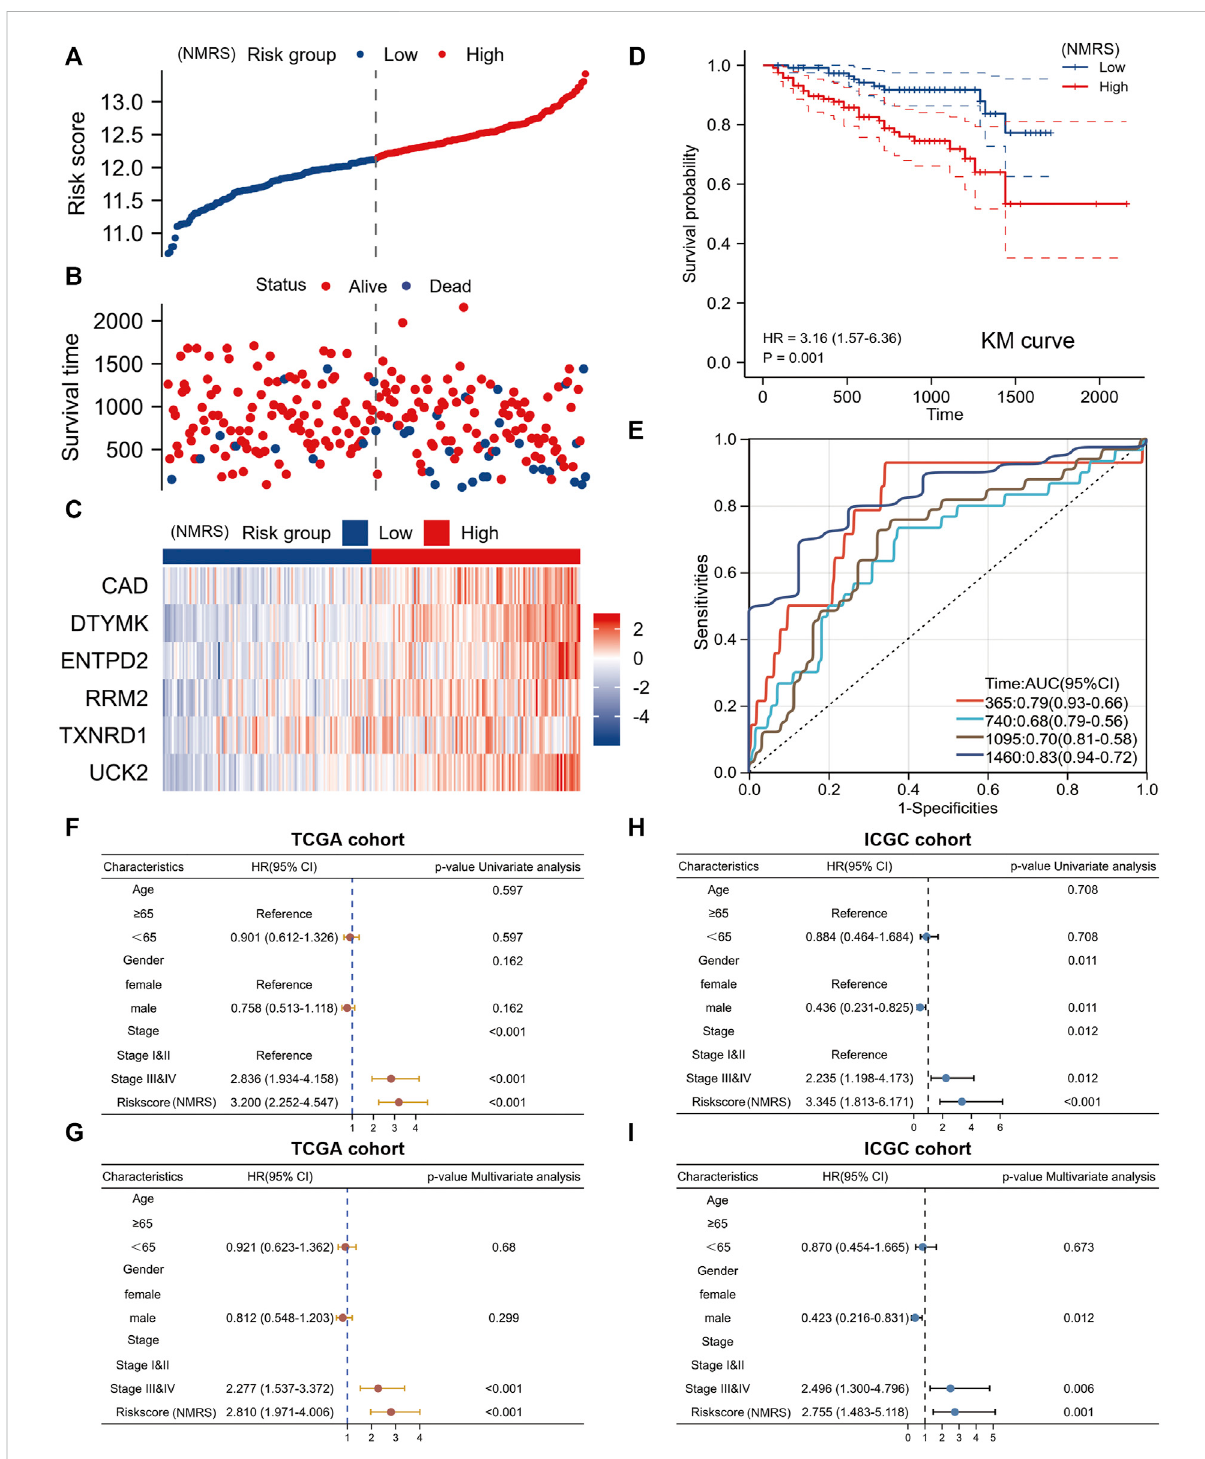
FIGURE 5 External validation set to verify model ef fi ciency. (A) NMRS of patients in the ICGC dataset are calculated based on formula. (B) The high NMRS group in the ICGC dataset has more dead patients. (C) Differences in expression of six genes in the ICGC database between high and low NMRS groups. (D) Prognostic differences between high and low NMRS groups in the ICGC database. (E) Time-dependent ROC curve of ICGC database. (F,G) UnivariateCoxandmultivariateCoxanalysesofNMRSintheTCGAdatabase. (H,I) UnivariateCoxandmultivariateCoxanalysis ofNMRSin the ICGC